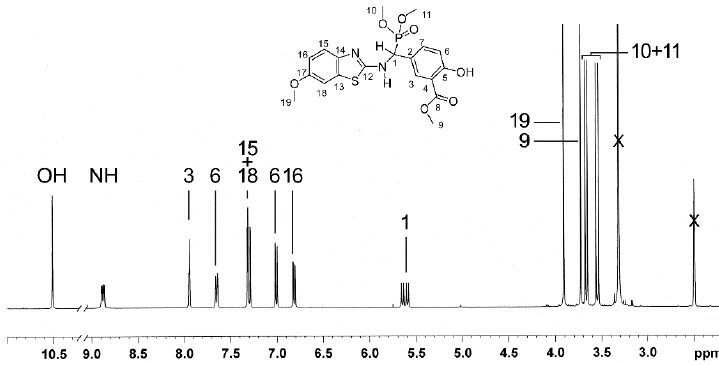
Figure 3. 1 H nuclear magnetic resonance (NMR) spectrum of compound 2 in dimethylsulfoxide (DMSO)-d 6 and full signal assignment.